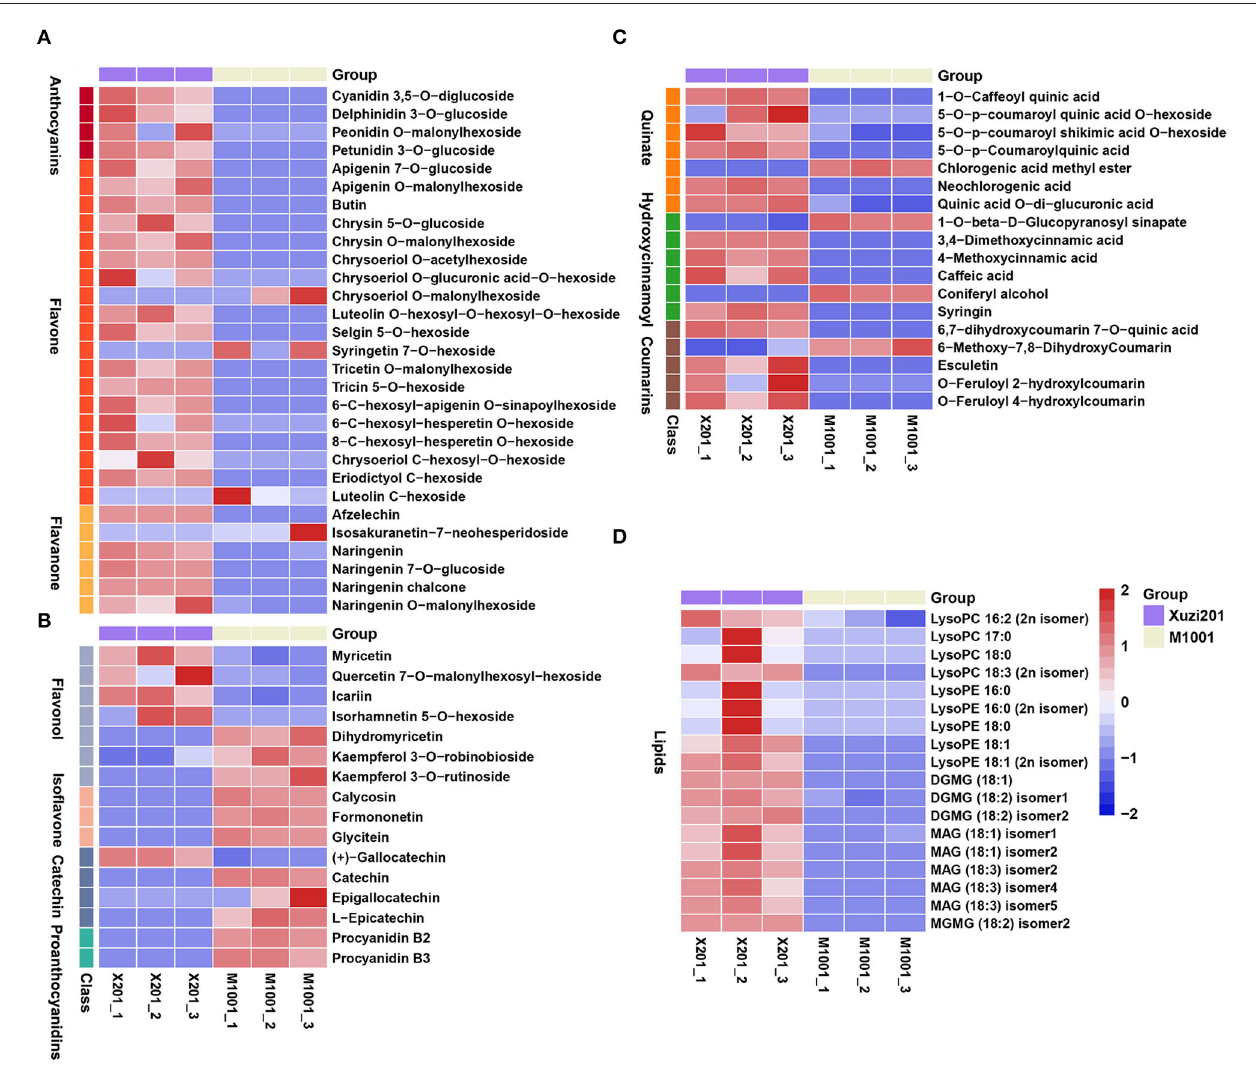
FIGURE 3 | Heatmap of differentially accumulated metabolites (DAMs) in Xuzi201 and M1001. (A) anthocyanins, flavones, and flavanone; (B) flavonol, isoflavone, catechin, and proanthocyanidins; (C) : phenylpropanoid compounds; (D) : lipids. The content of each metabolite was scaled. Each example is visualized in a single column, and each metabolite is represented by a single row. Red indicates high abundance, whereas low relative metabolites are shown in blue.